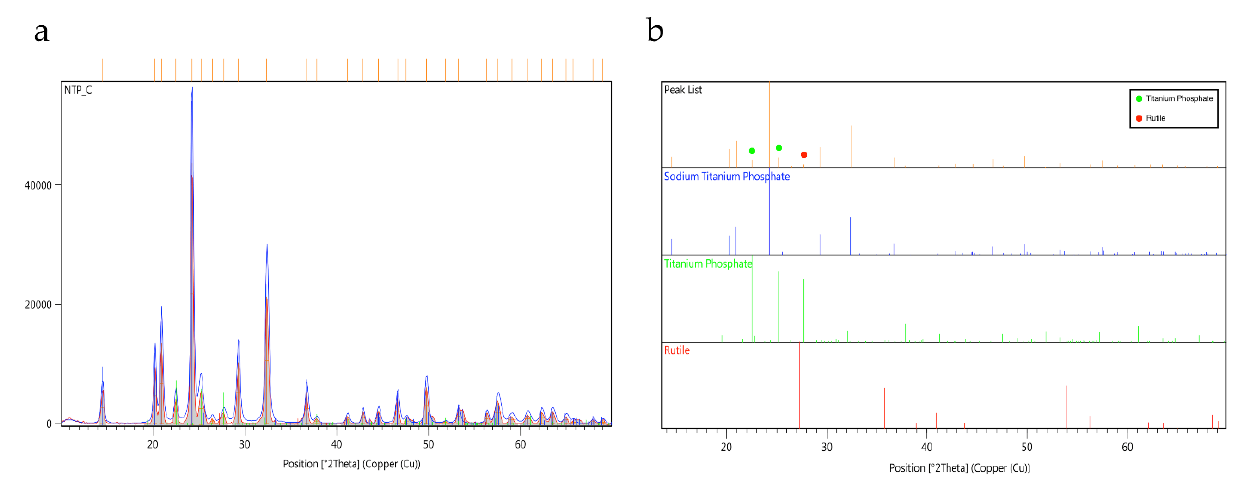
Figure A1. ( a ) XRD spectrum of NTP, ( b ) comparison of NTP peak list with reference compounds.